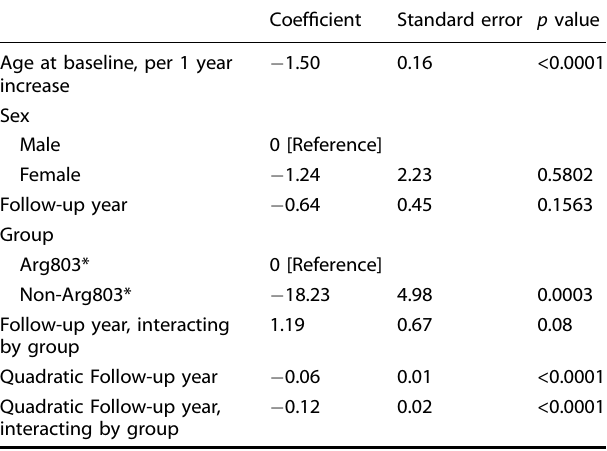
Table 4. Longitudinal renal function decline in individuals with